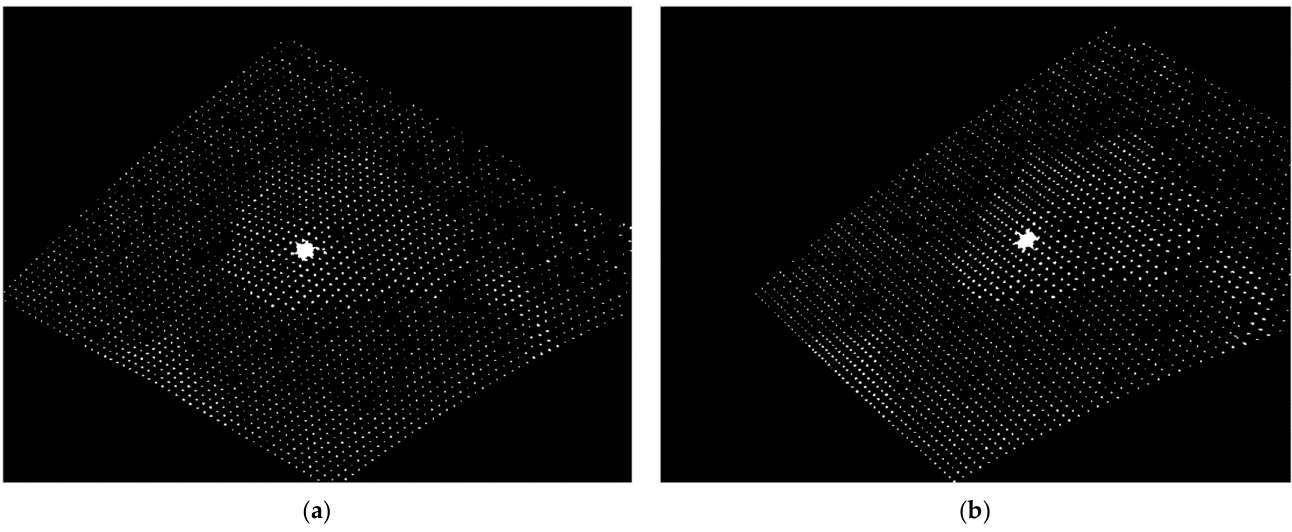
Figure 18. Images resulting from the processing of measurement photographs: ( a ) left camera image and ( b ) right camera image.